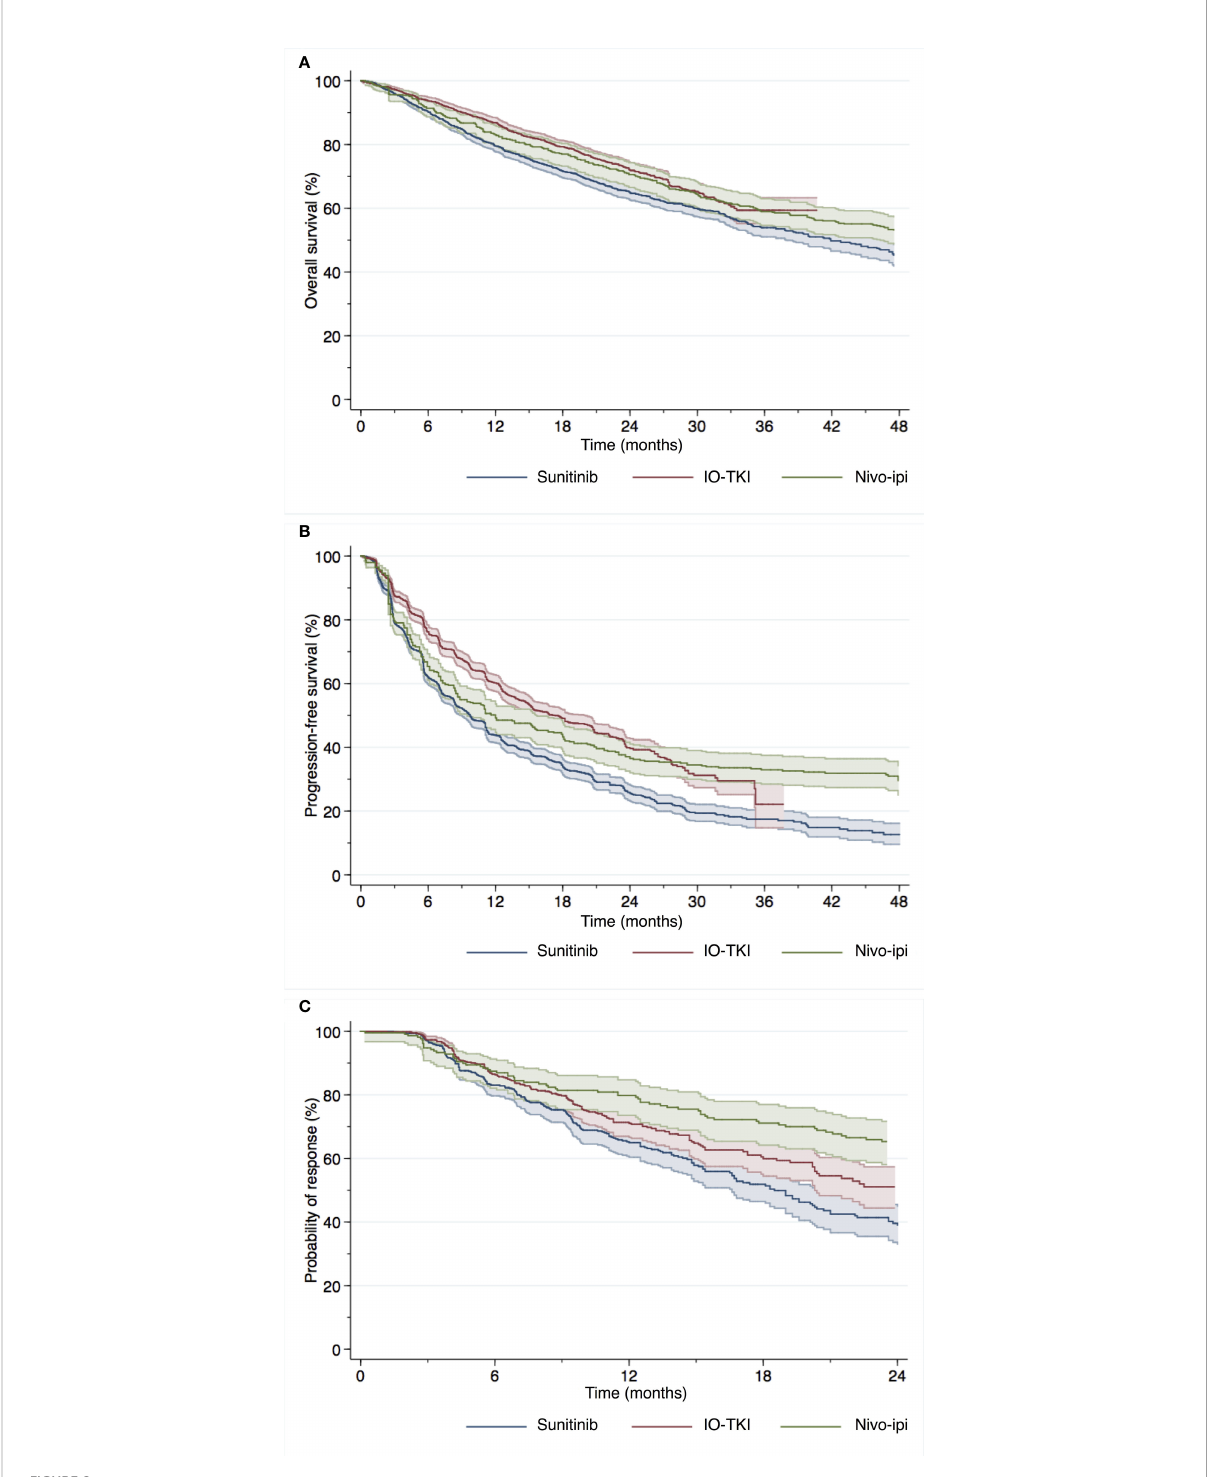
FIGURE 2 Overall survival (A) , progression-free survival (B) and duration of response (C) of mRCC patients using reconstructed survival data derived from fi ve individual studies with immune-oncology based combination